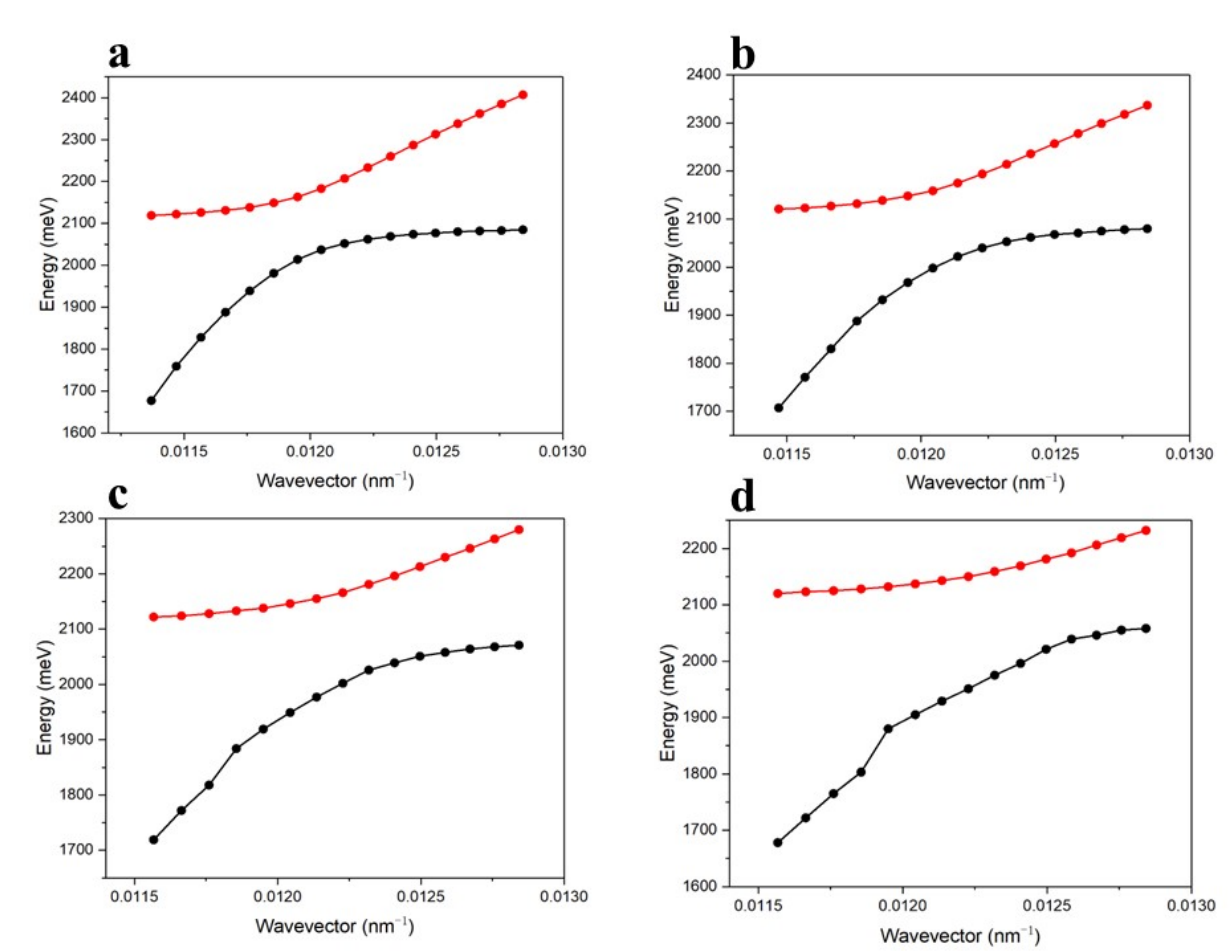
Figure 3. The strong coupling effect regulated by the thickness of the MoS 2 layers. The thickness of the Ag film is 42 nm, and the thickness of the graphene is a monolayer. ( a – d ): The number of MoS 2 layers is 0–3. The red and black dotted lines, respectively, represent the upper and lower energy branches produced by the strong coupling effect of the polaron–exciton system.